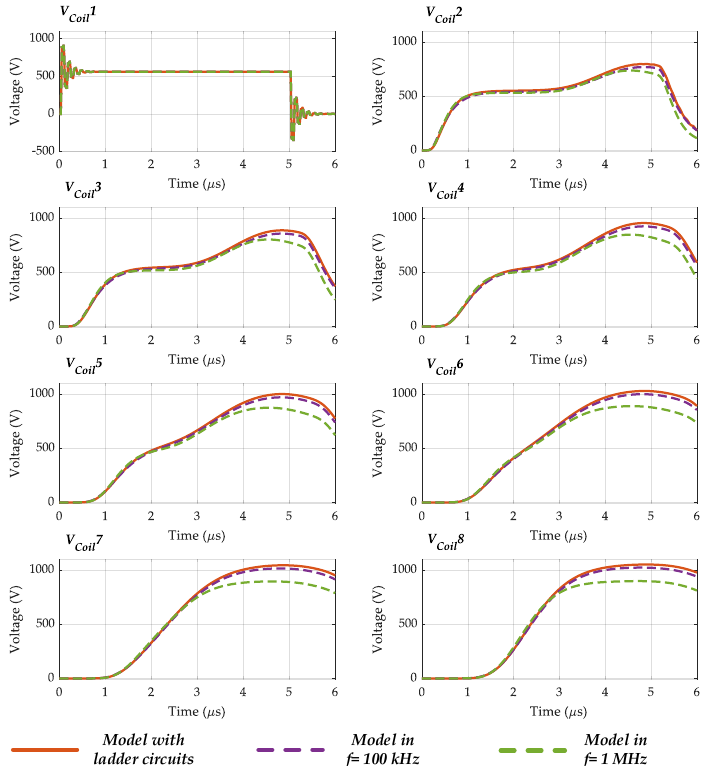
Figure 25. The voltages in different coils when the MCTL model with ladder circuits is developed and fixed-frequency models are developed; the neutral point is floating.